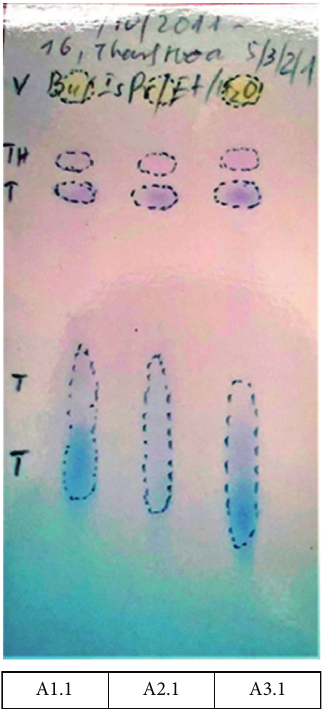
Figure 4: HPTLC of questioned samples A1.1, A2.1, and A3.1 developed in system A—butanol/isopropanol/ethanol/water (5:3: 2:1